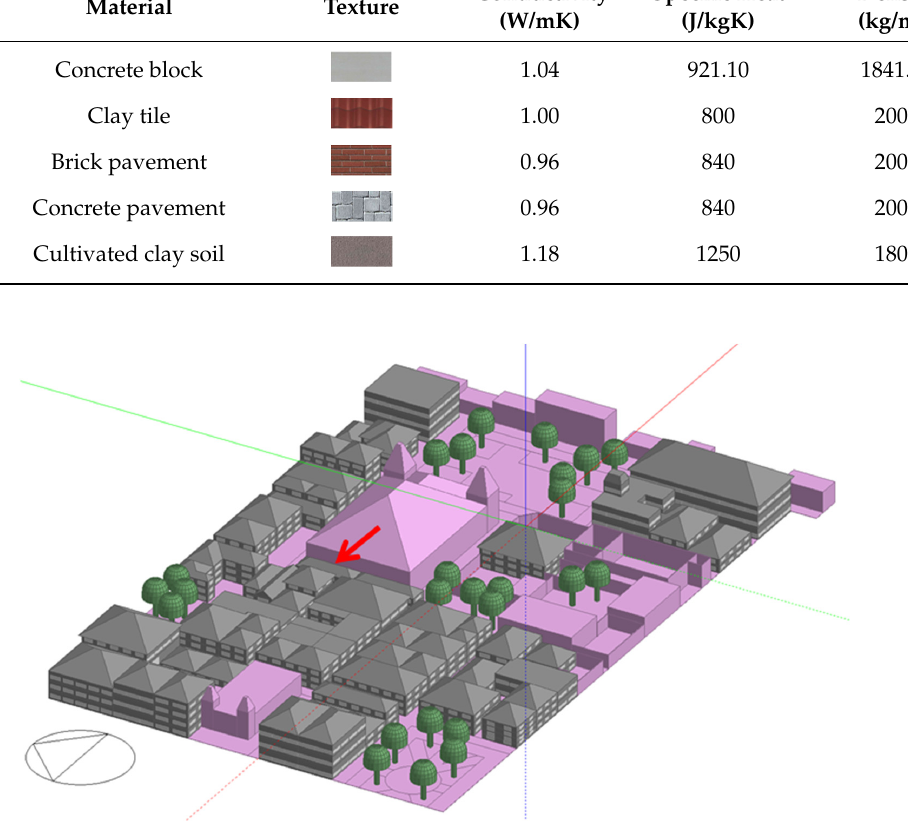
Figure 3. Base case 3D model in Designbuilder. Own elaboration.